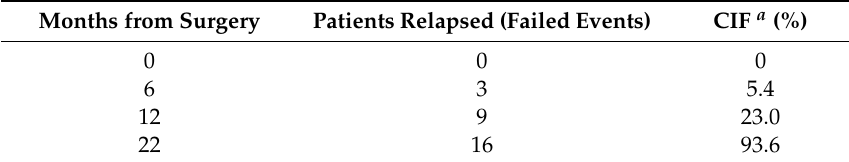
Table 4. Overall cumulative relapse incidence.